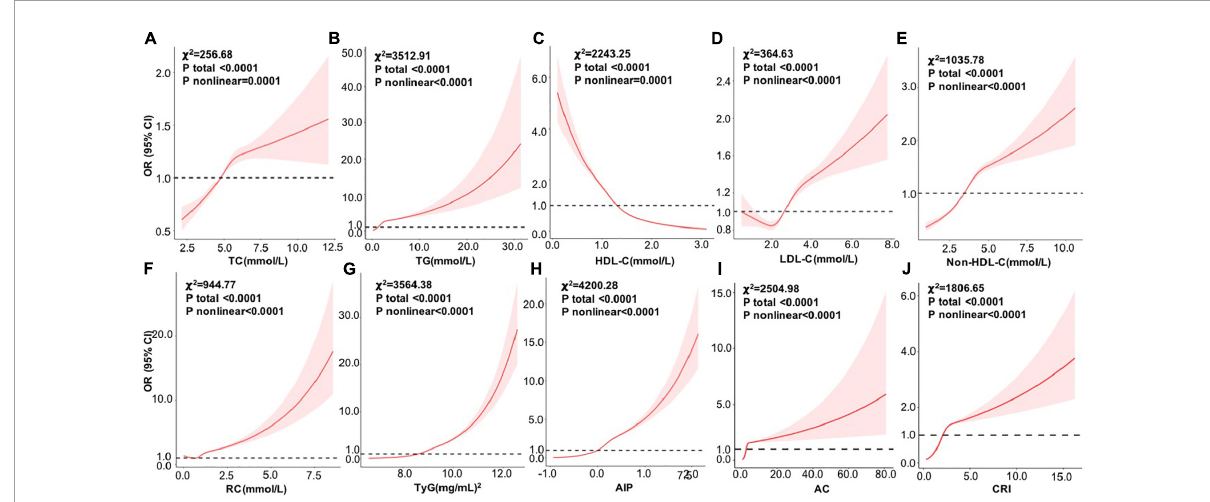
FIGURE2 Dose–response relationships between variables and the risk of NAFLD by RCS analysis after adjusting age, sex, BMI, SBP, DBP, ALT, AST, GGT, TP, TBIL, Cr, UA, and glucose ( n = 112200). (A) TC; (B) TG; (C) HDL-C; (D) LDL-C; (E) non-HDL-C; (F) RC; (G) TyG; (H) AIP, (I) AC; and (J) CRI. RCS, restricted cubic spline; OR, odds ratio; BMI, body mass index; SBP, systolic blood pressure; DBP, diastolic blood pressure; ALT, alanine aminotransferase; AST, aspartate aminotransferase; GGT, glutamyl transpeptidase; TP, total protein; TBIL, total bilirubin; Cr, creatinine; UA, uric acid; TC, total cholesterol; TG, triglyceride; HDL-C, high-density lipoprotein cholesterol; LDL-C, low-density lipoprotein cholesterol; RC, remnant cholesterol; TyG, triglyceride glucose; AIP, atherogenic index of plasma; AC, atherogenic coefficient; CRI, coronary risk index.